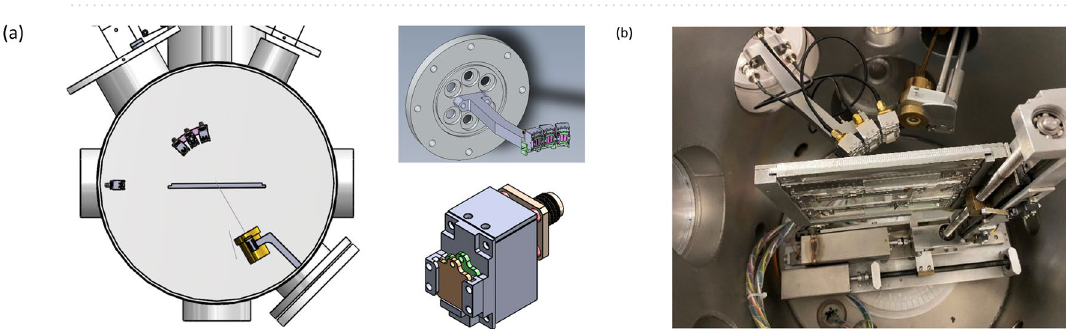
Figure 17. ( a ) Simulation of multi-detector holder kindly provided by S. Steydli, INSP, ( b ) set up of three pin detectors with 100 µm mylar in front of the